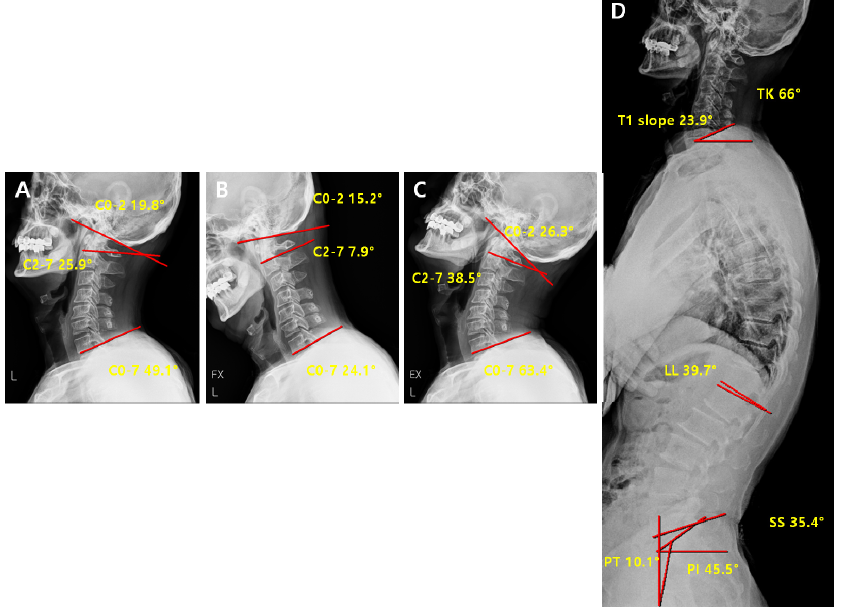
Figure 7. Post-operative radiological parameter in lordosis groups. Cervical spine lateral X-ray of neutral ( A ), flexion ( B ), extension ( C ) and whole-spine lateral X-ray ( D ). In the lordosis group, the significant changes in the parameters before and after surgery were observed in C0-2 angle ( p < 0.01), C0-7 angle ( p = 0.03), C0-2ROM ( p = 0.02), C2-7ROM ( p < 0.01), C0-7ROM ( p < 0.01), C0-2/C0-7 ( p < 0.01), and C2-7/C0-7 ( p < 0.01) (Table 5). After the surgery, the angle of c-spine (C0-7 angle) was maintained as lordotic, and C0-7ROM and C2-7ROM decreased, while C0-2 ROM and C0-2/C0-7ROM increased. These results suggest that the ROM of the cervical motion, which was reduced in the lordosis group after the surgery, was compensated through the upper cervical motion (C0-2). No statistically significant difference was observed in the other cervical and spinopelvic parameters (Table 5).